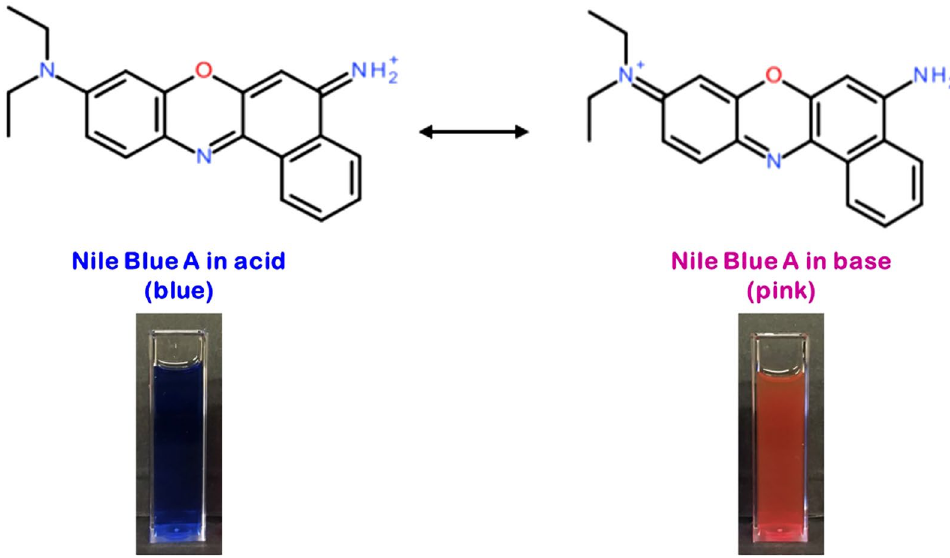
Figure 8. Reversible protonation and deprotonation states of Nile Blue A.